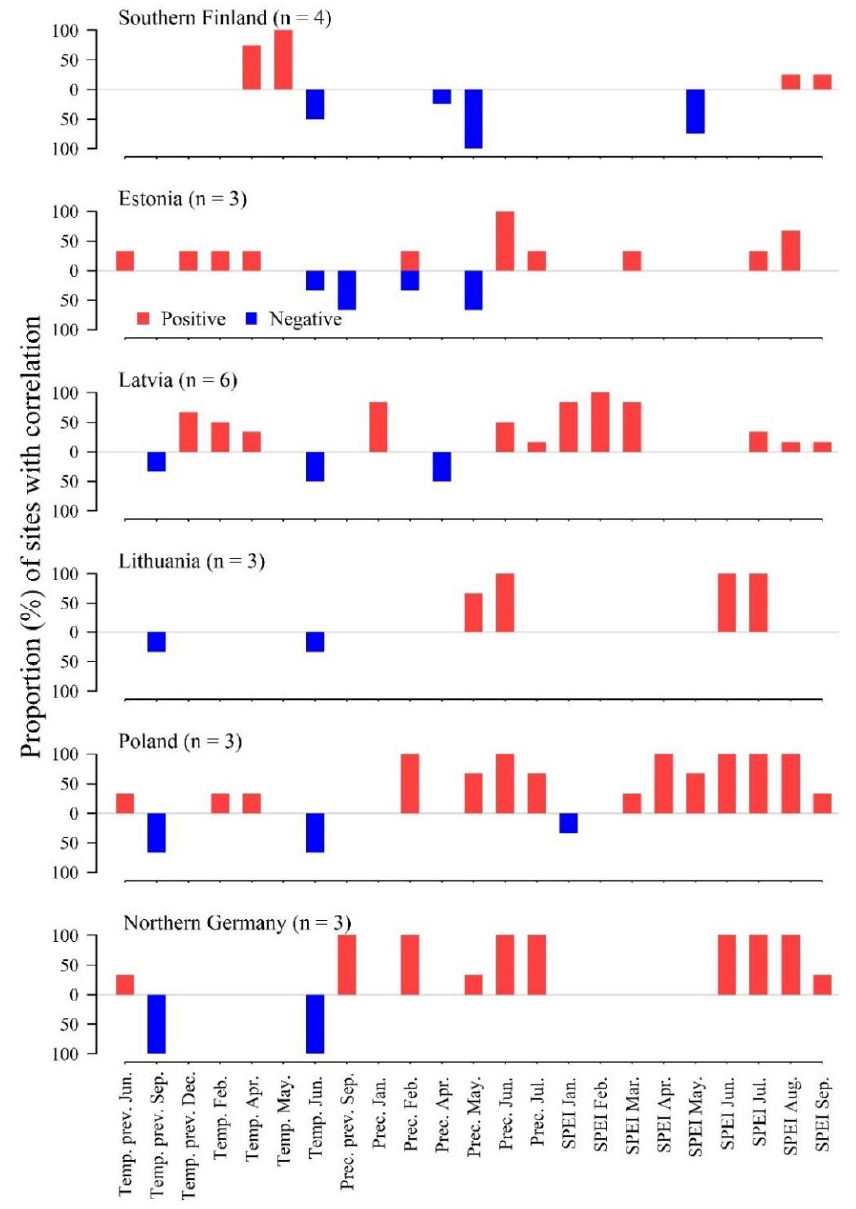
Figure 2. The proportion of stands of Norway spruce showing significant ( p -value < 0.05) Pearson correlation coefficients between the residual chronologies of tree-ring width and meteorological variables: monthly mean temperature (Temp.), precipitation sums (Prec.), and standardized precipitation evapotranspiration index (SPEI) by countries. The bars below zero represent the negative correlations. The analysis was conducted for the 1954–2017 period. Only the meteorological variables showing significant correlations are shown.